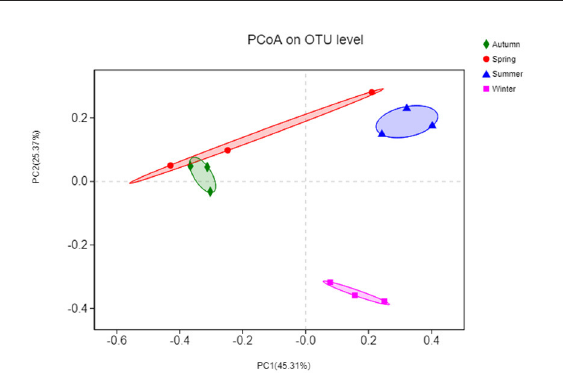
FIGURE7 Principal coordinates analysis (PCoA) based on the numbers of OTUs in the bacterial communities. The x-axis shows the first principal component and the y-axis shows the second principal component. Data points shown with different colors represent groups of samples under different conditions.